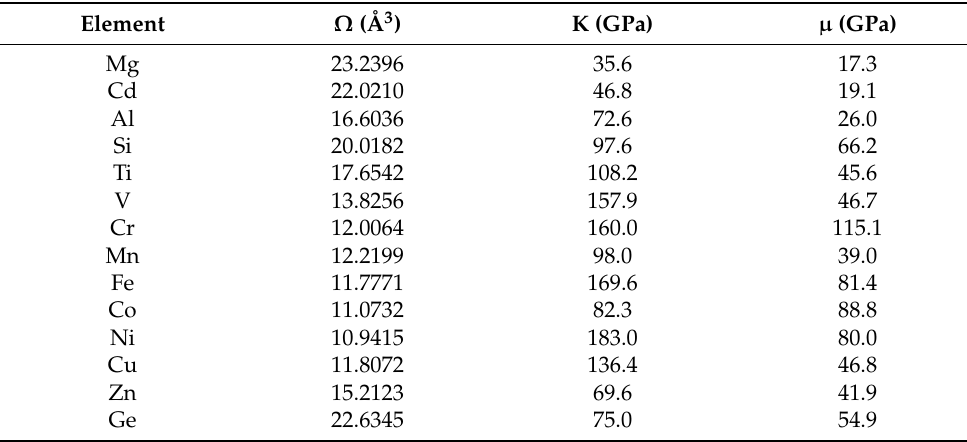
Table 1. The experimental atomic volumes and elastic constants for polycrystalline metals [11].